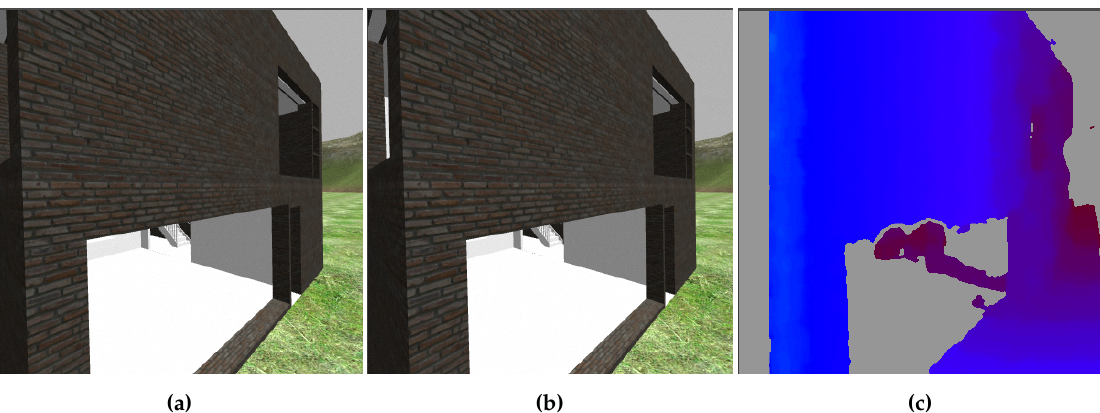
Figure 3. A visualisation of the generation of the disparity map. ( a , b ) Images from cameras mounted next to each other. ( c ) The resulting disparity map with a colour gradient indicating perceived